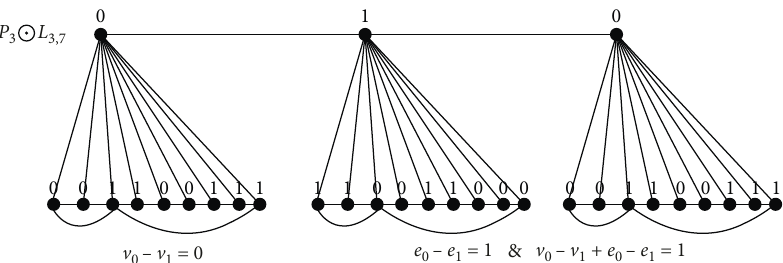
Figure 1: Cordial and total cordial labeling of P